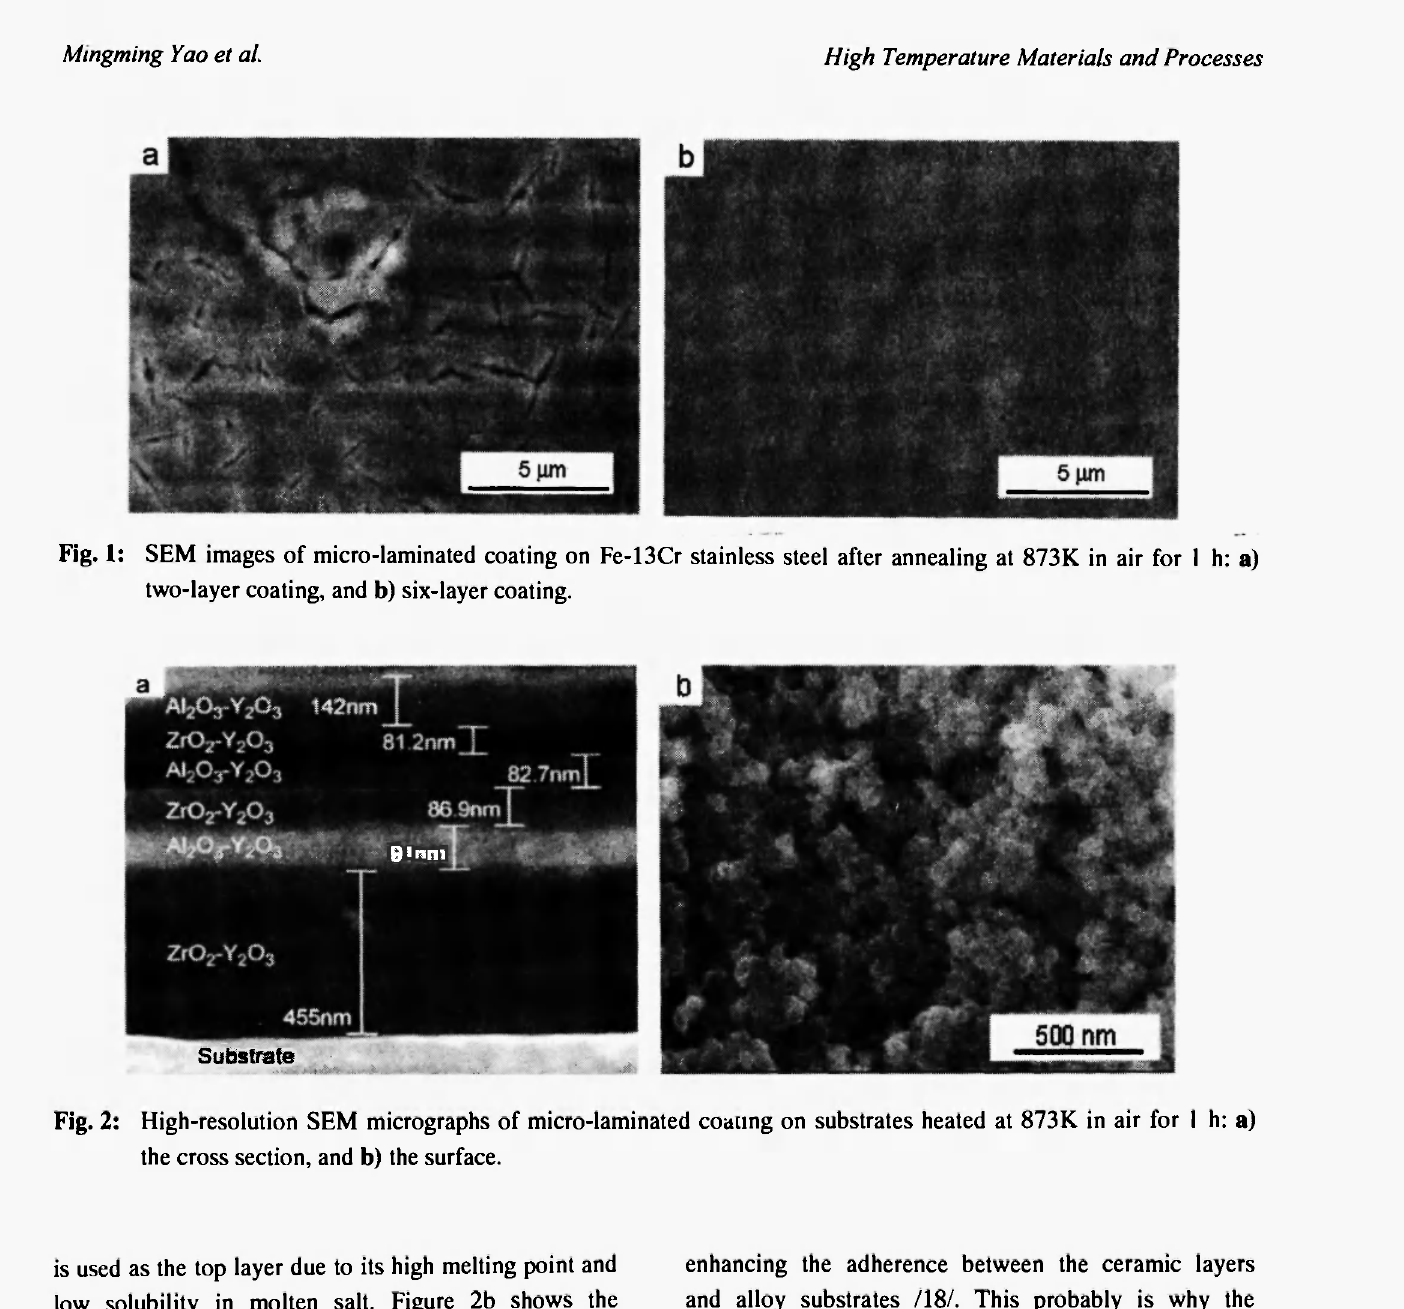
Fig. 2: High-resolution SEM micrographs of micro-laminated coating on substrates heated at 873K in air for 1 h: a) the cross section, and b) the